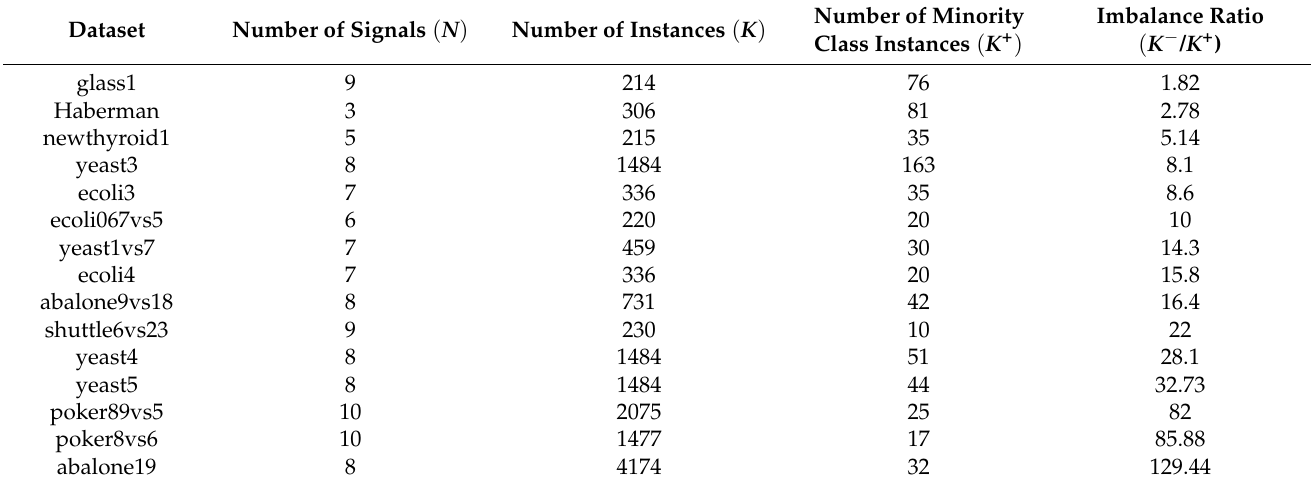
Table 1. Characteristics of the considered benchmark